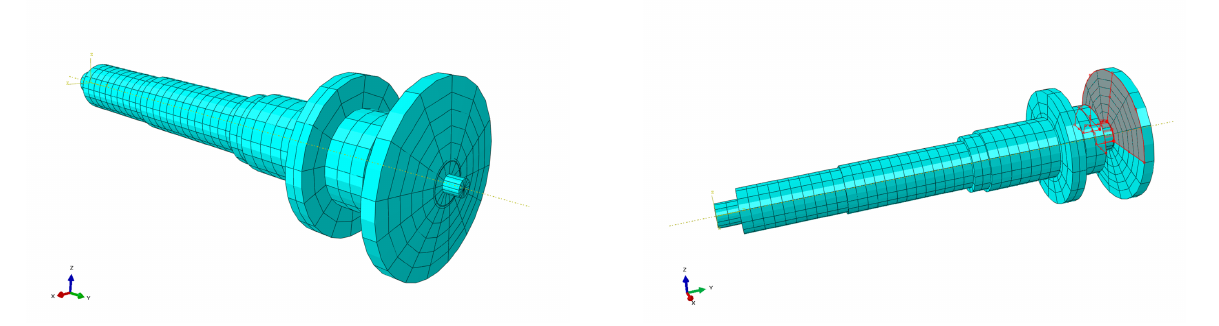
Figure 1: The finite element model of the micro-turbine rotor used to analyze the thermal phenomena.